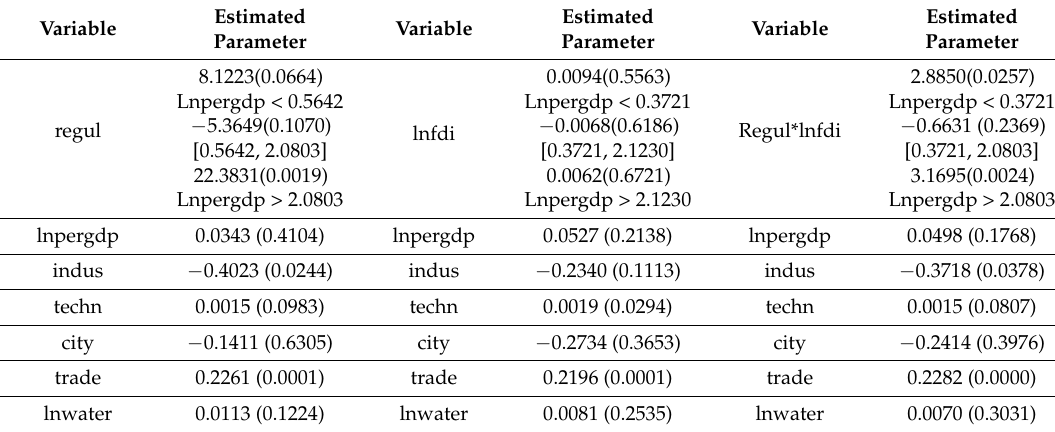
Table 4. Estimation results and tests of each threshold regression